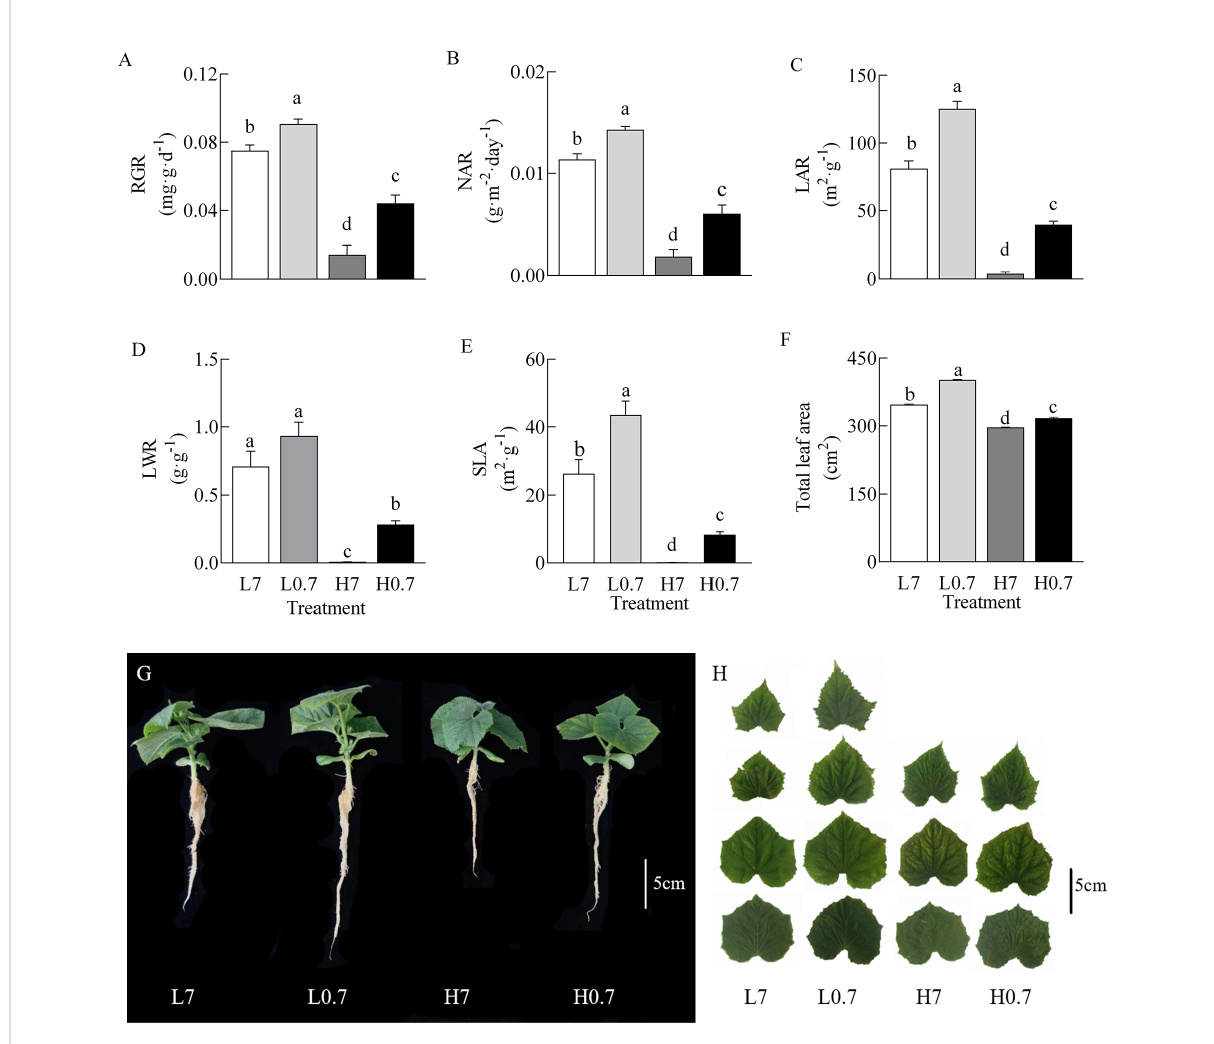
FIGURE 2 Effect of R/FR on growth parameters of cucumber seedlings under salt stress. (A) , RGR, relative growth rate; (B) , NAR, net assimilation rate; (C) , LAR, leaf area ratio; (D) , LWR, leaf dry weight ratio; (E) , SLA, speci fi c leaf area; (F) , total leaf area; Cucumber seedlings (G) and total true leaves (H) on day 9 after treatment. L7, 0 mM NaCl and R/FR=7; L0.7, 0 mM NaCl and R/FR=0.7; H7, 80 mM NaCl and R/FR=7; H0.7, 80 mM NaCl and R/FR=0.7. Different letters indicate signi fi cant differences (P< 0.05; n=